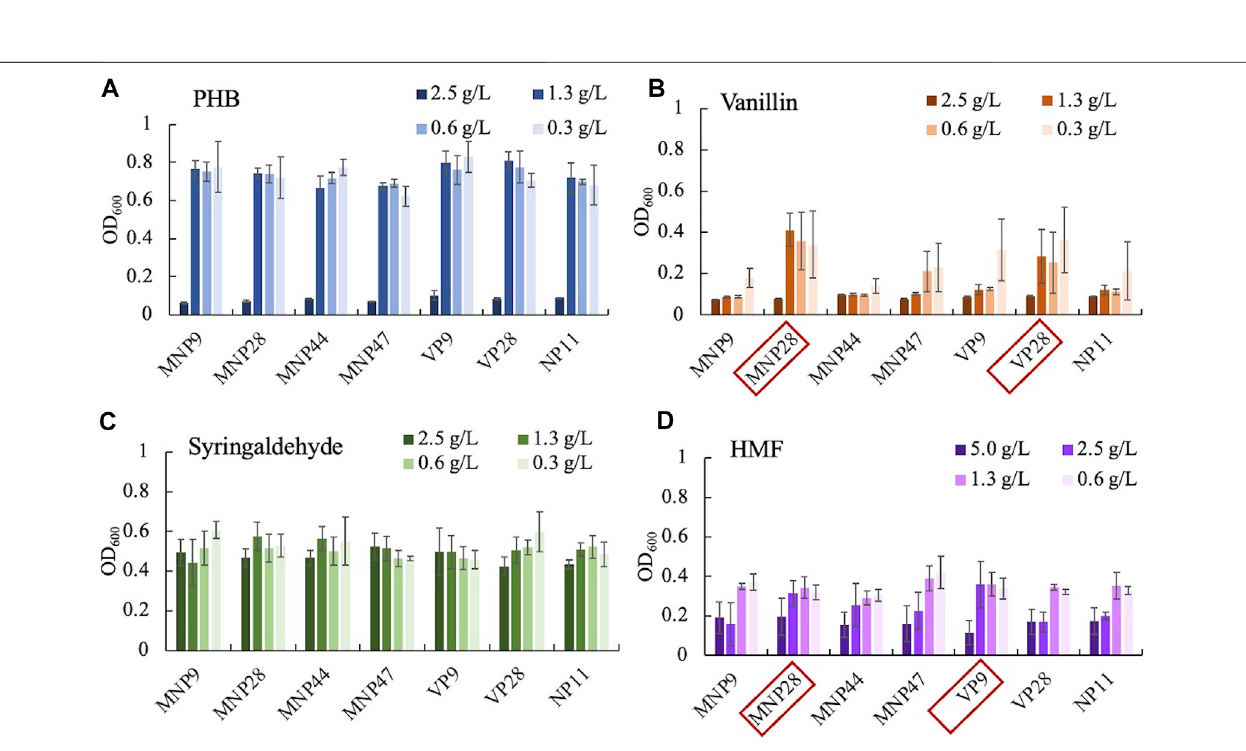
FIGURE1| Integrationofexogenousgenes MNP and VP with R.toruloides chromosomes: (A) hypotheticmetabolizepathwayofphenolicaldehydesandHMF; (B) information of gene expression cassettes; (C) R. toruloides colony PCR results for MNP and VP genes veri fi cation. Red dots represent right genotypes chose for further screening.